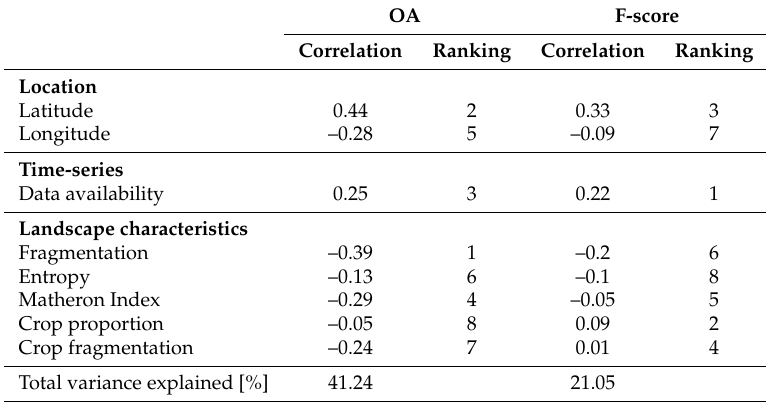
Table 3. Correlation and importance rank for Overall accuracy (OA) and F-score computed on eight potential explanatory variables.